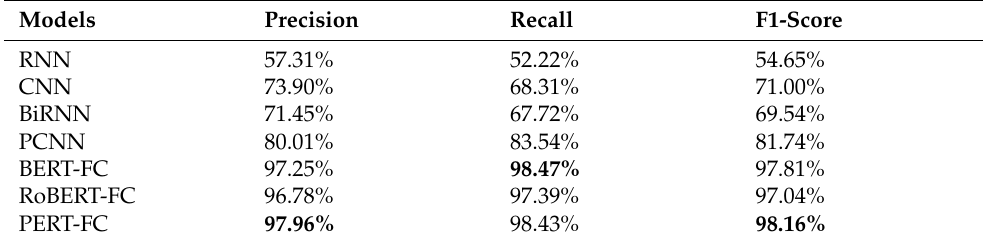
Table 8. Comparison of relation extraction